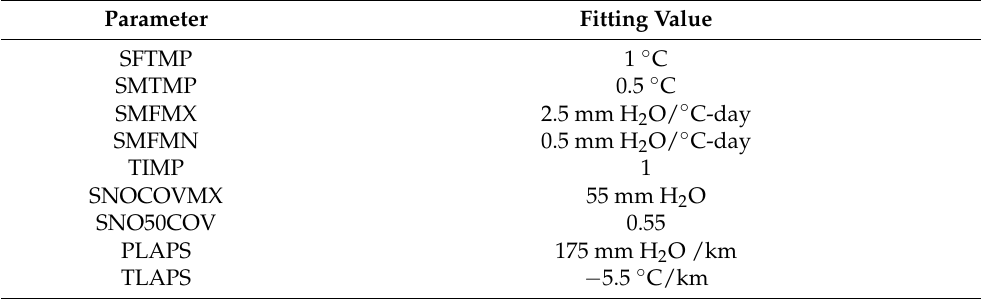
Table 4. Fitted snow parameters and lapse rates.